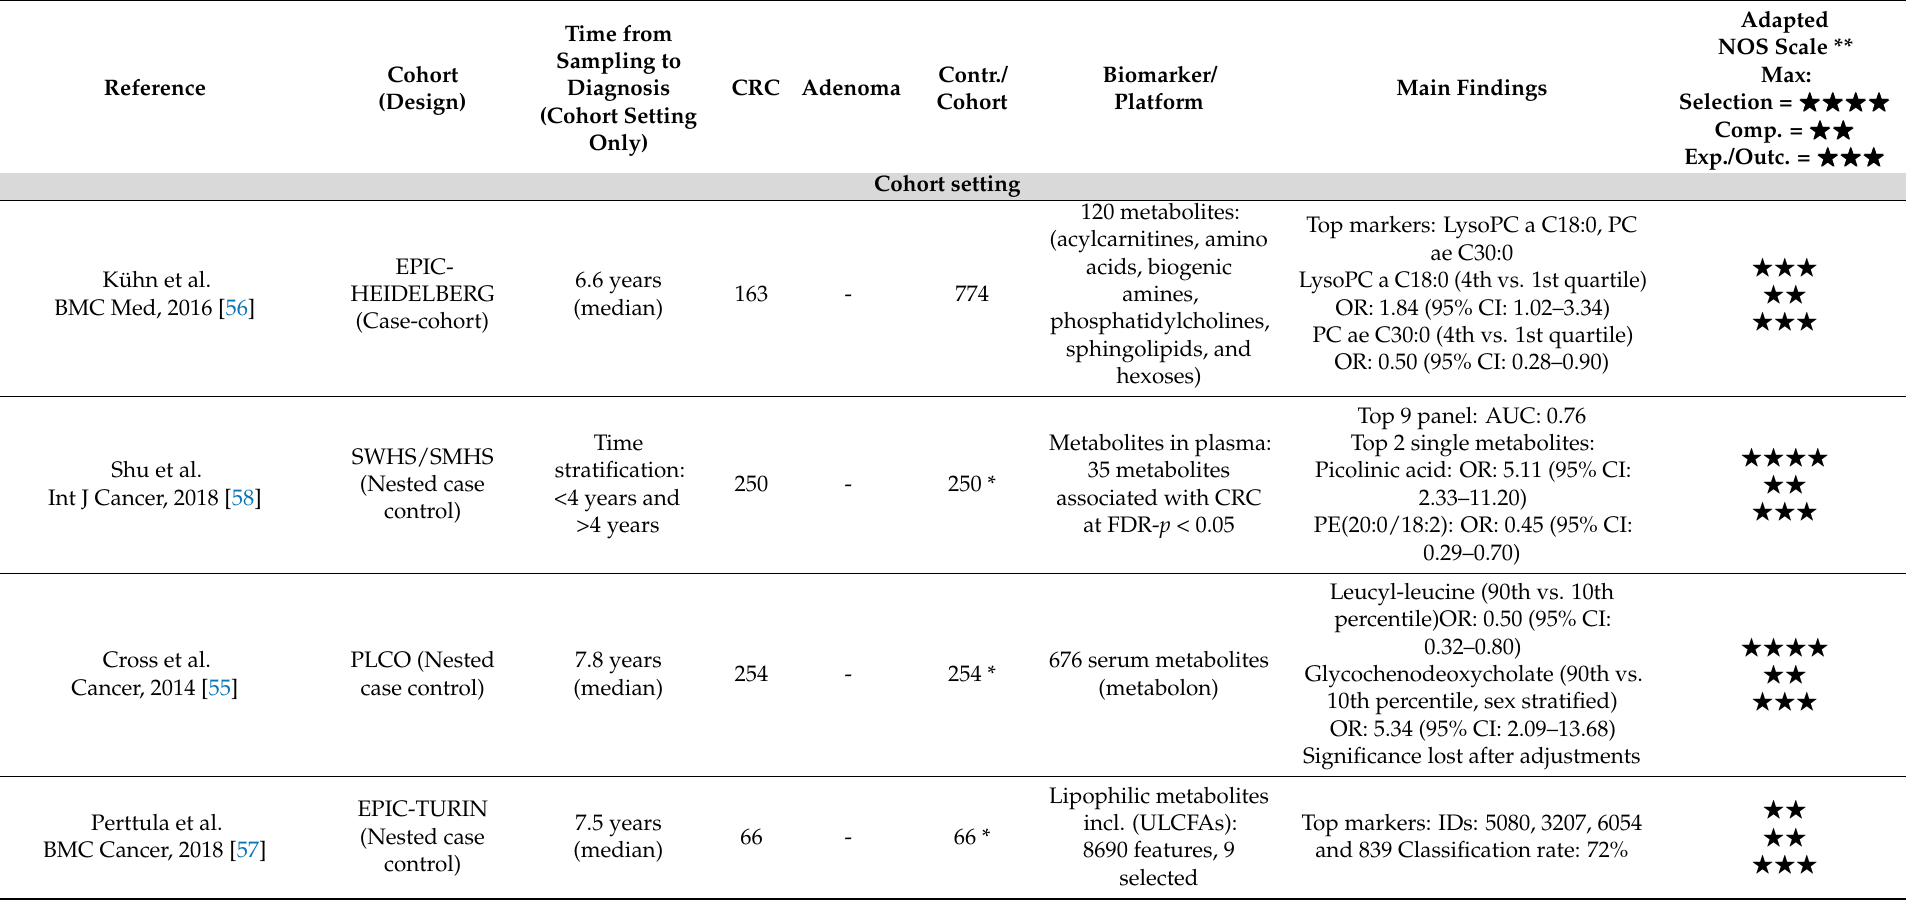
Table 2. Studies of metabolites analyzed in pre-diagnostic blood samples (collected in prospective cohort or general screening settings) for the purpose of risk prediction or early diagnosis of colorectal